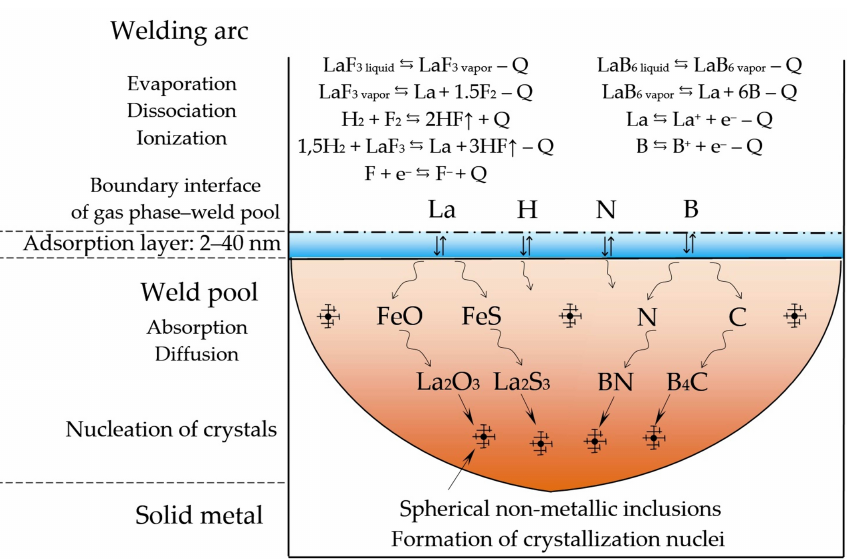
Figure 8. The model of metallurgical processes occurring in the welding arc and in weld pool when lanthanum fluoride and lanthanum boride are introduced and refractory non-metallic inclusions are